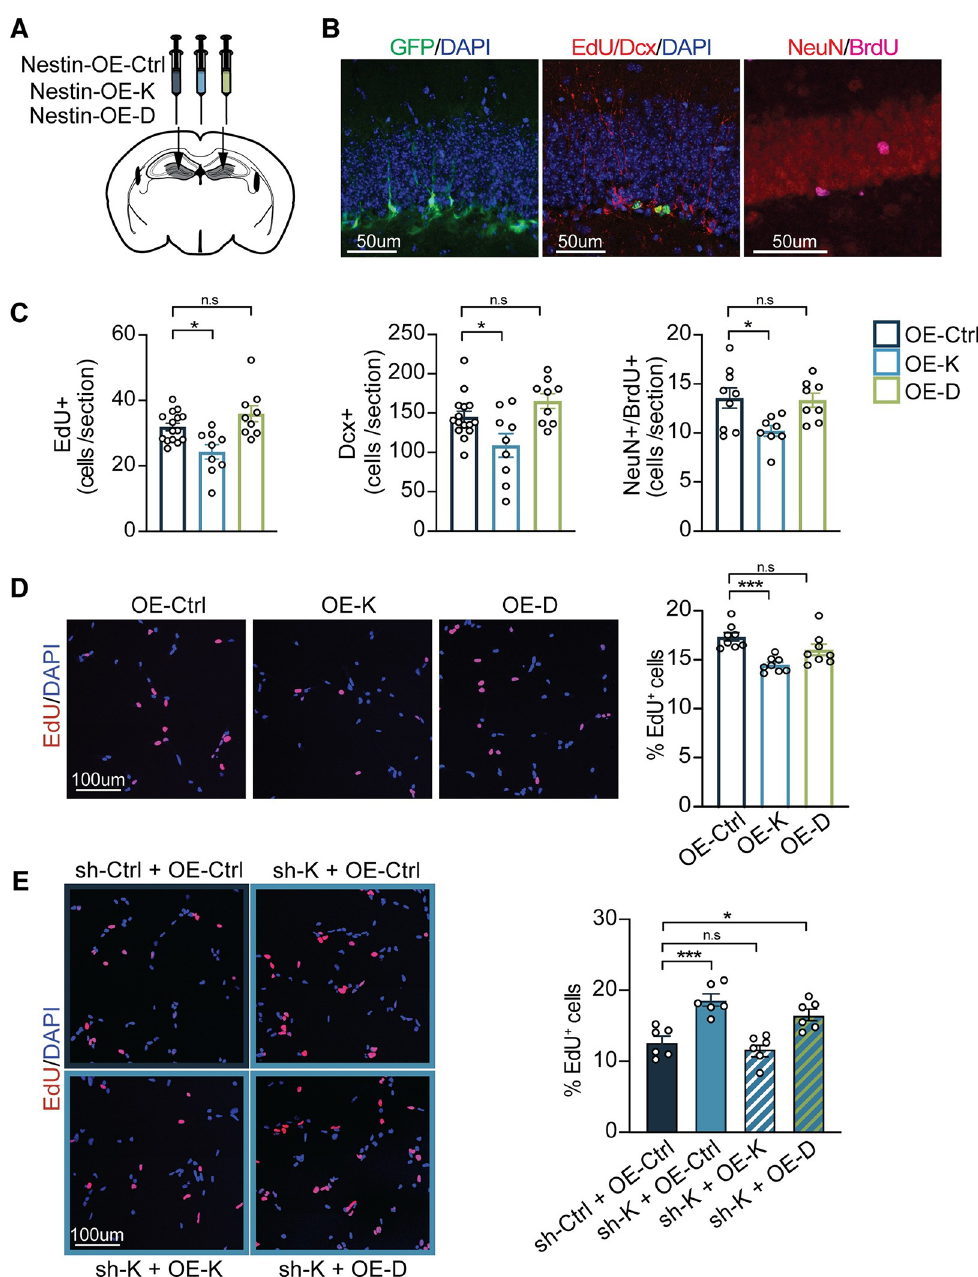
Fig 2. H2-K b overexpression decreases NSPC proliferation and impairs adult hippocampal neurogenesis. Ten-week- old adult WT mice were stereotaxically injected with lentiviruses expressing H2-K b (OE-K), H2-D b (OE-D), or GFP control (OE-Ctrl) under the Nestin promoter (A). (B) Representative fields of Nestin-GFP expressing cells (left panel), EdU + short-term proliferating cells, Dcx + neuroblasts (middle panel), and adult-born neurons coexpressing BrdU and NeuN (right panel) in the DG. (C) Quantification of EdU + , Dcx + , and BrdU + /NeuN + cells in the DG. n = 8–15 animals/ group (3–4 sections/animal); scale bars: 50 μ m. (D) WT adult NSPC were infected with OE-K, OE-D, and OE-Ctrl lentiviruses and grown under self-renewal conditions. Representative images (left panels) and quantification (right panel) of the percentage of EdU + proliferating NSPCs after 6 hours of EdU treatment. n = 8 replicates/group; scale bars: 100 μ m. (E) WT adult NSPC were infected with sh-K or sh-Ctrl, followed by infection with OE-K, OE-D, or OE-Ctrl lentiviruses. Representative images (E, left panel) and quantification (E, right panel) of EdU + proliferating NSPCs after 6 hours of EdU treatment. n = 6 replicates/group; scale bar: 100 μ m. Data represented as mean ± SEM. One-way ANOVA with Dunnett’s multiple comparisons test; � p < 0.05, ��� p < 0.001. Data used to generate this figure can be found in the Supporting information Excel spreadsheet (S1 Data). BrdU, 5-bromo-2 0 -deoxyuridine; Dcx, Doublecortin; DG, dentate gyrus;